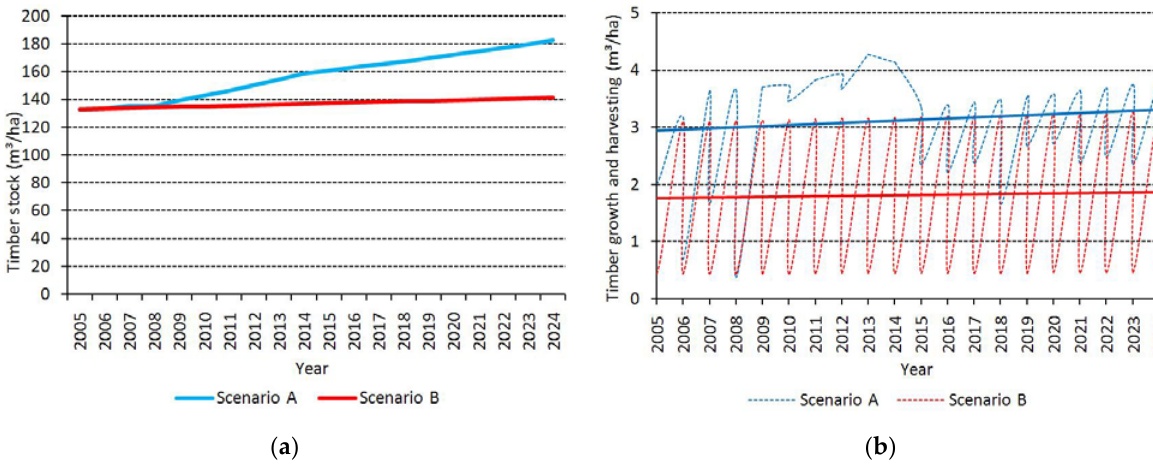
Figure 2. Timber growth, harvesting and stock in the studied scenarios. ( a ) Change in timber stock (m³/ha·y) in the studied scenarios; ( b ) Changes in timber growth (m³/ha·y) and harvesting (m³/ha·y) in the studied scenarios.